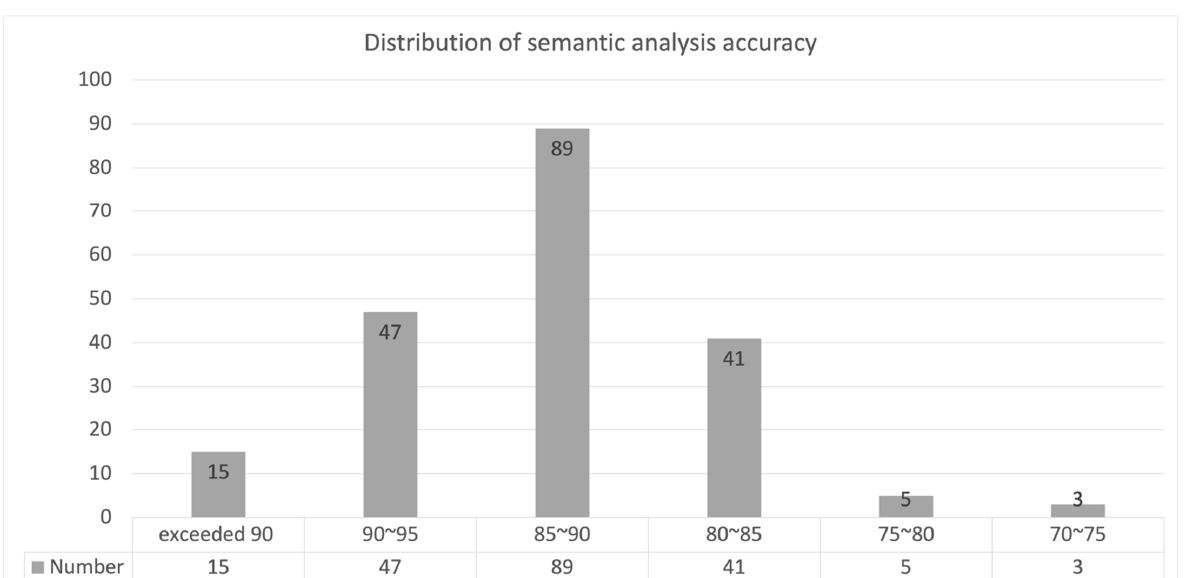
Figure 9. Chi-square statistic and prior probability search method.